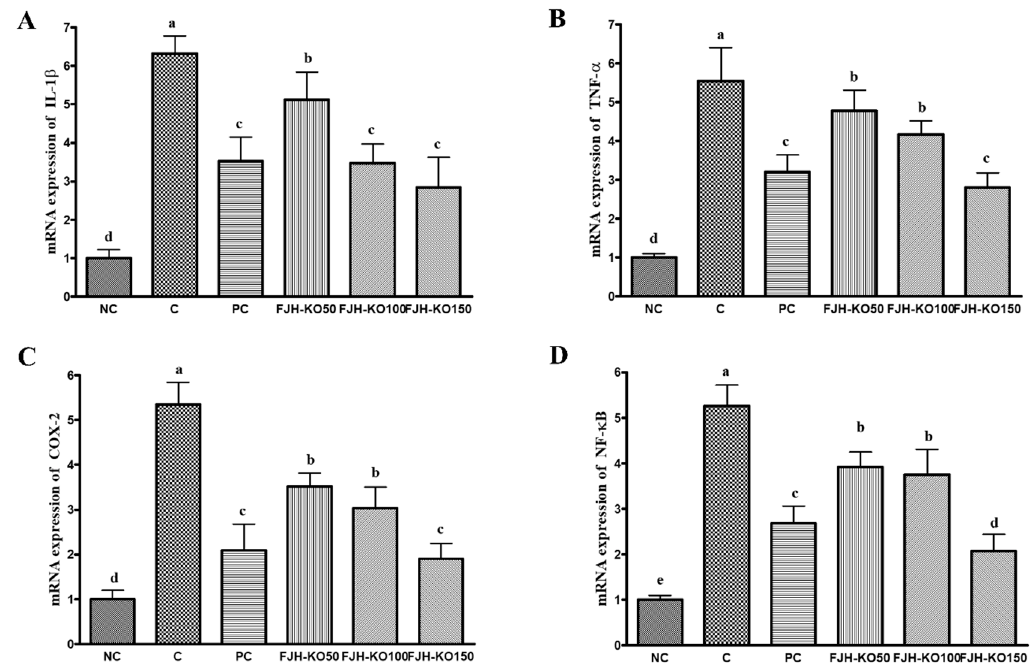
Figure 5. Effect of krill oil on mRNA expression of inflammatory mediators in rat model with or without induced osteoarthritis by MIA. ( A ) IL-1 β , ( B ) TNF- α , ( C ) COX-2, ( D ) NF- κ B. NC: AIN93G